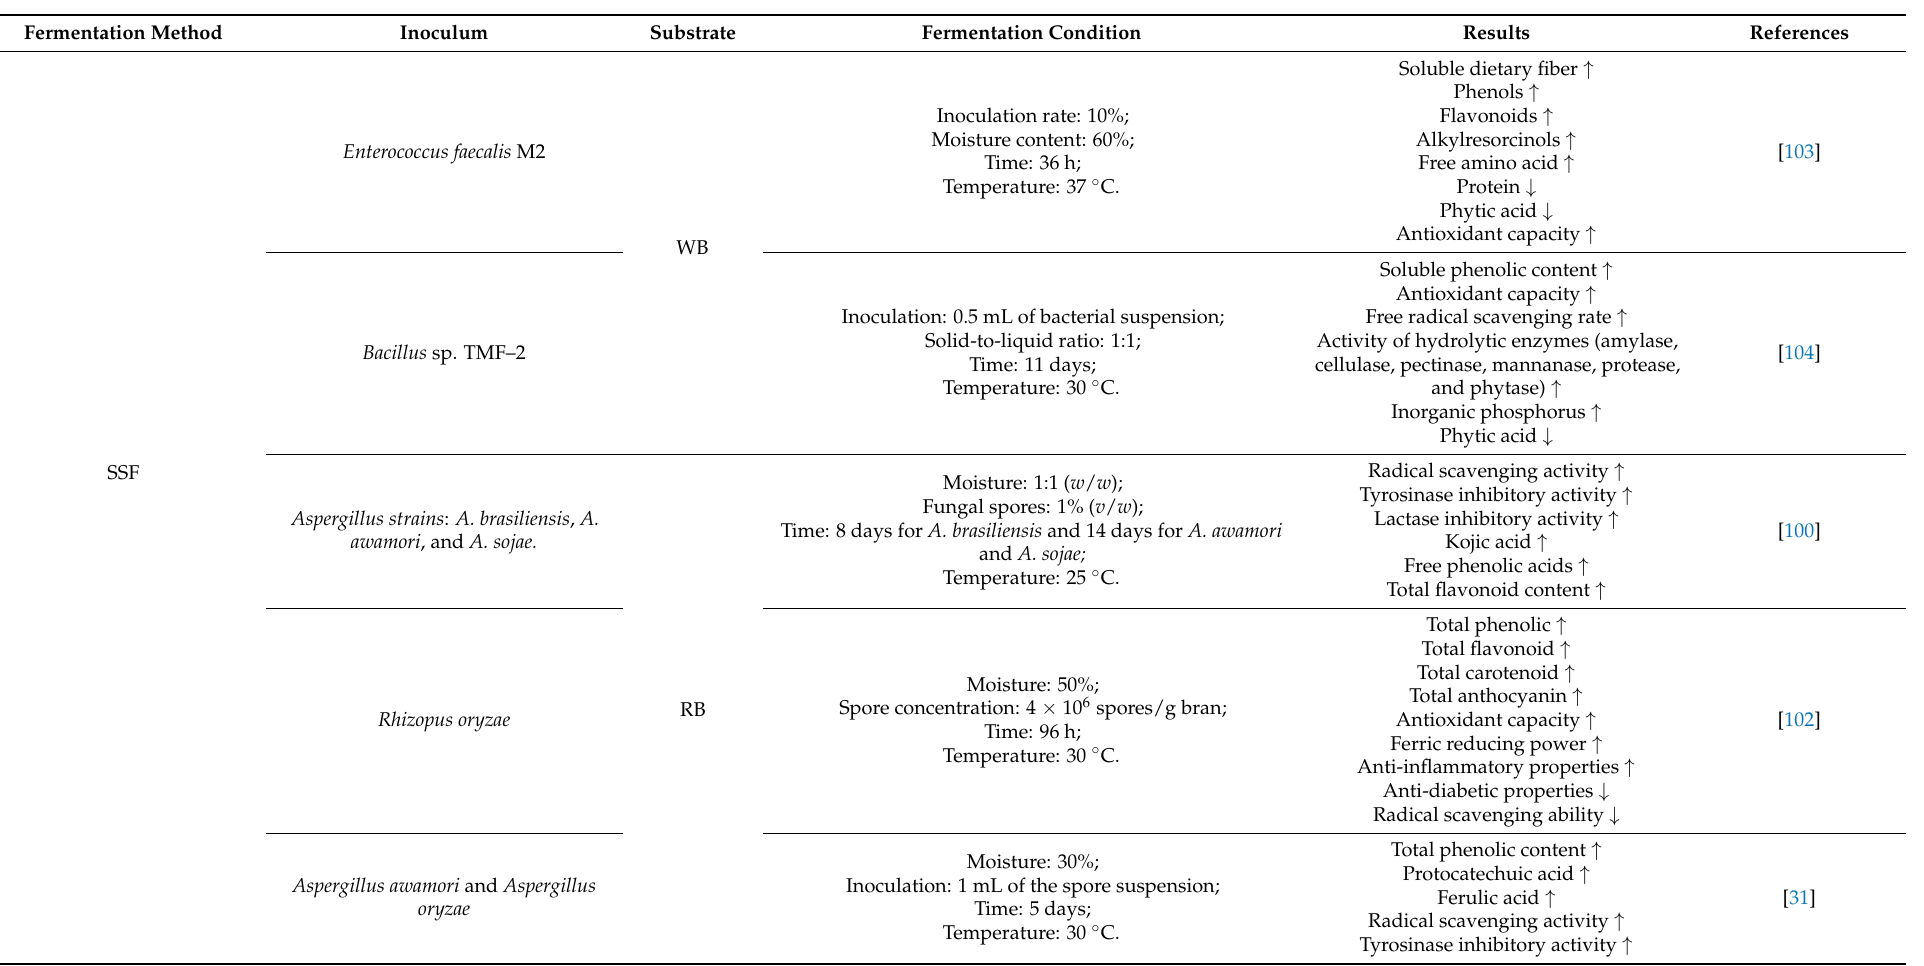
Table 3. SSF and SmF applied to cereal